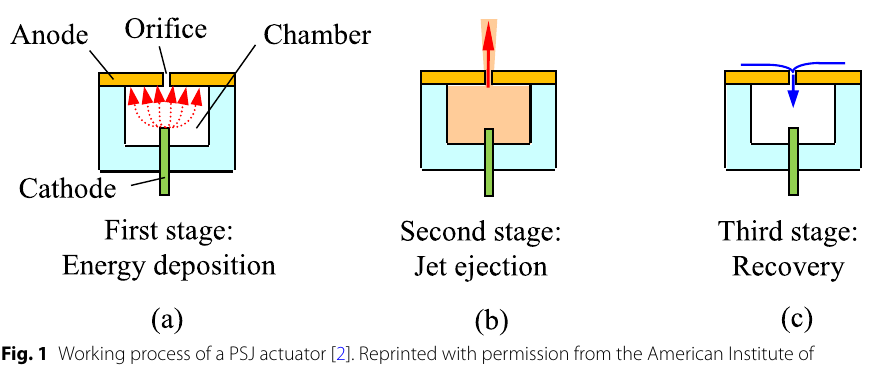
Fig. 1 Working process of a PSJ actuator [2]. Reprinted with permission from the American Institute of Aeronautics and Astronautics,